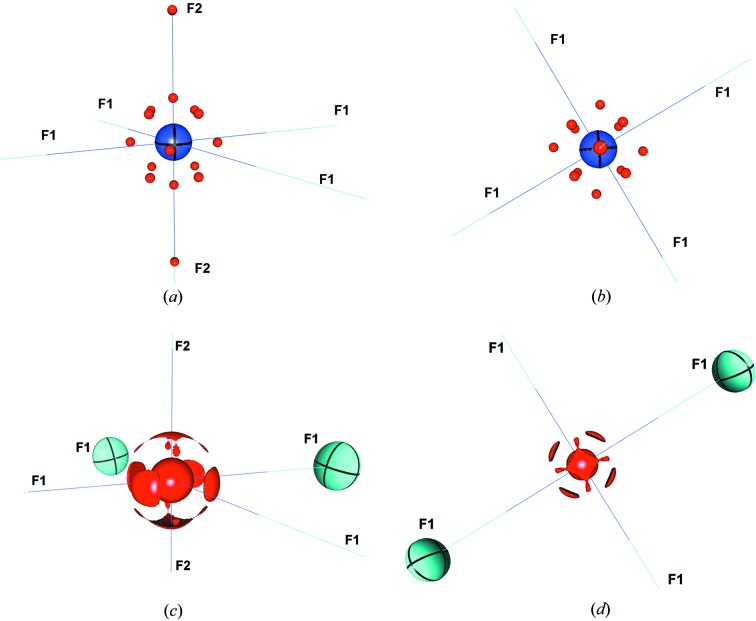
Envelope diagrams [(c) and (d)] of the negative Laplacian distribution (charge concentration) around the U atom in the UF6
− anion plotted at the −280 e Å−5
­ level. The corresponding (3, +3) critical points (maxima of charge concentration) of the Laplacian distribution [(a) and (b)] are depicted as red spheres. The directions of the fluorine ligands are indicated by labels, except for the axial F2 atoms in (b) and (d), where the axial ligands are above and below the plane of the image. When depicted, thermal ellipsoids are drawn at the 99% probability level. Although these distributions were obtained from model 1c, nearly identical distributions are obtained from model 1b. U–cp distances are in the range 0.37–0.38 Å for the 14 nearest cps and 1.075 Å for the distant cp. The F2–cp distance is 1.001 Å.